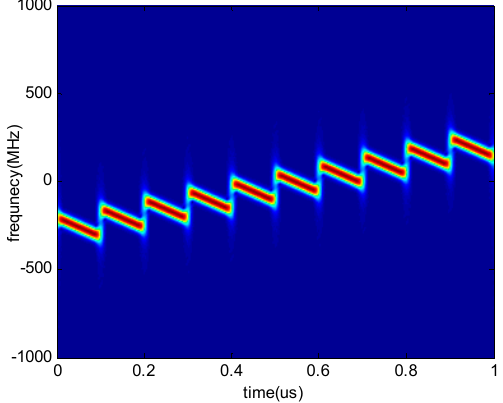
Figure 4. Time-frequency diagram of a sampled LFM signal using periodic LFM local oscillator (LOS).